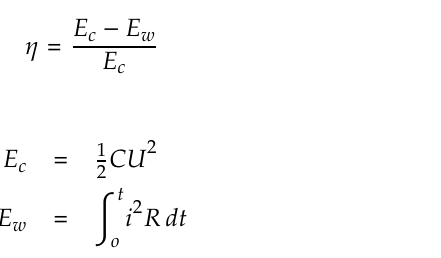
Figure 7. Sectional view of two-electrode SparkJet. Adapted from [49].